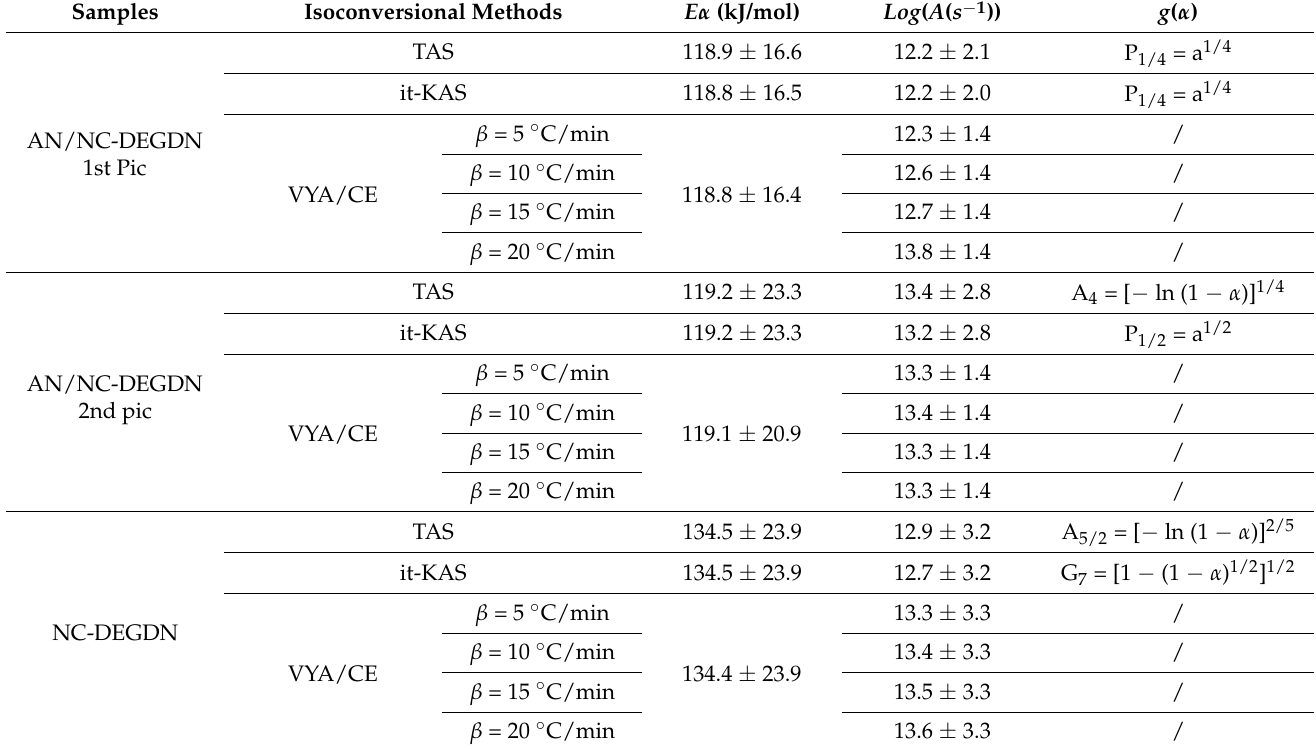
Table 2. Thermo-kinetic parameters of the elaborated energetic